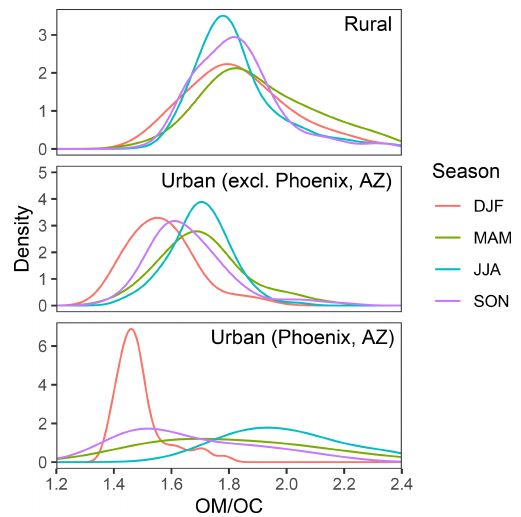
Figure 9. Probability densities of OM / OC estimated by FTIR for sites included in Fig. 8, separated by site type. Densities for urban sites are separated into Phoenix, AZ, which is shown in its own panel, and the remaining five